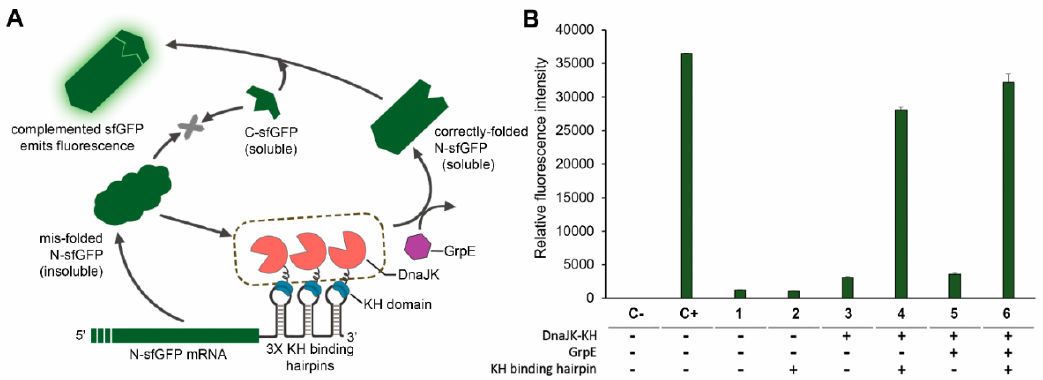
Figure 3. Monitoring CRAS system in vivo solubilization activity. ( A ) Scheme representing a split GFP experiment to monitor CRAS system in vivo protein solubilization activity: A superfolder GFP (sfGFP) is split in two fragments with a highly insoluble N terminal part (N-sfGFP) and soluble C terminal part (C-sfGFP). Introducing three KH binding hairpin loop repeats to the N-sfGFP mRNA 3 (cid:48) UTR targets this sfGFP part for solubilization by the DnaJK-KH CRAS system. Solubilized N-sfGFP complements C-sfGFP, emitting fluorescence. ( B ) in vivo N-terminal sfGFP solubilization using the CRAS system; fluorescence intensity of E. coli BL21(DE3) cells harboring the indicated CRAS system components including DnaJK-KH, KH binding hairpin, and GrpE, was determined at 488 nm λ exc and 530 nm λ em . C − is negative control (empty plasmid) and C + is positive control (expresses full-length sfGFP). The illustrated GrpE in ( A ) is either expressed from E. coli genome (GrpE was not presented in the expression plasmid), indicated as ( − ), or overexpressed from a plasmid, indicated as ( + ). Samples 1–6 show di ff erent combinations of the sfGFP expression and CRAS units, as indicated by the absence, shown by the symbol ( − ), and presence, shown by the symbol ( + ), of each component. Error bars in ( B ) represent ± s. d. from three independent experiments.